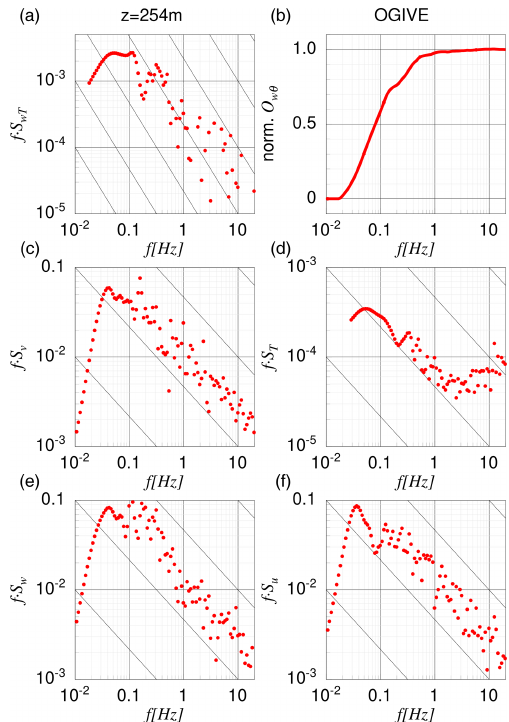
Figure A1. Frequency-weighted power spectra ( S u , S v , S w for wind components; S t for temperature; and S wT for temperature flux) and ogive O w,θ as measured on 5 June 2017 in the cloud at 254m